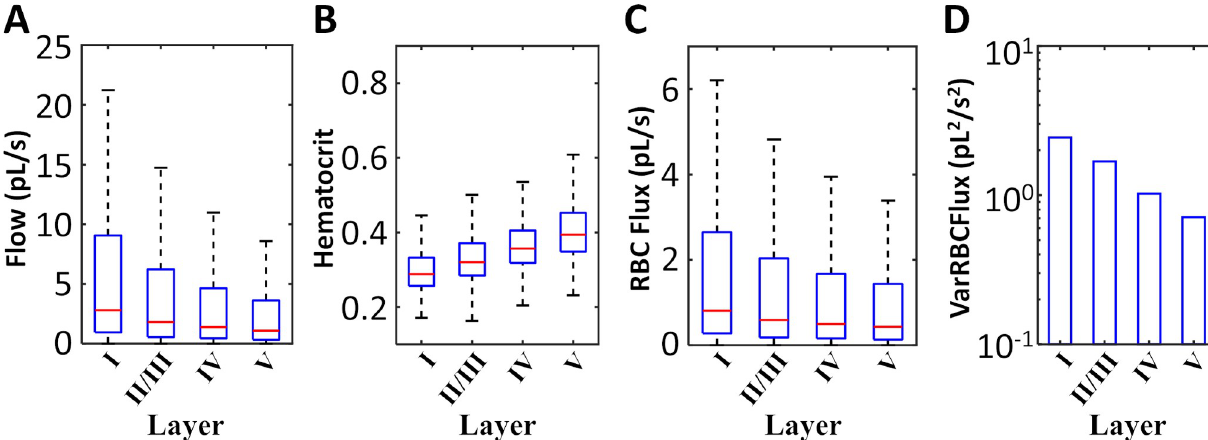
Fig 7. Depth dependence of hematocrit on total blood flow in the center MCA territory. Biphasic blood flow simulations for the entire MCA territory were analyzed statistically to illustrate depth dependence of hemodynamic states. In a large subsection cut out of the center MCA cortical vasculature (with volume = 4.1 mm 3 and surface area = 4.2 mm 2 which equals 11% of the MCA territory), 188,865 microvascular segments in layers I-V were assessed. (A) Blood flow slightly decreases in deeper paths (p < 0.01 using one-way ANOVA test). (B) Hematocrit increase along deeper cortical layers (p < 0.01, one-way ANOVA test). (C) The product of bulk blood flow and hematocrit gives the RBC flux, which is almost constant with a mild decrease with depth (p < 0.01 using one-way ANOVA test). (D) The variance of RBC flux ( VarRBCFlux ) decreases with depth, so RBC flux distribution is more homogenous in deeper layers than close to the